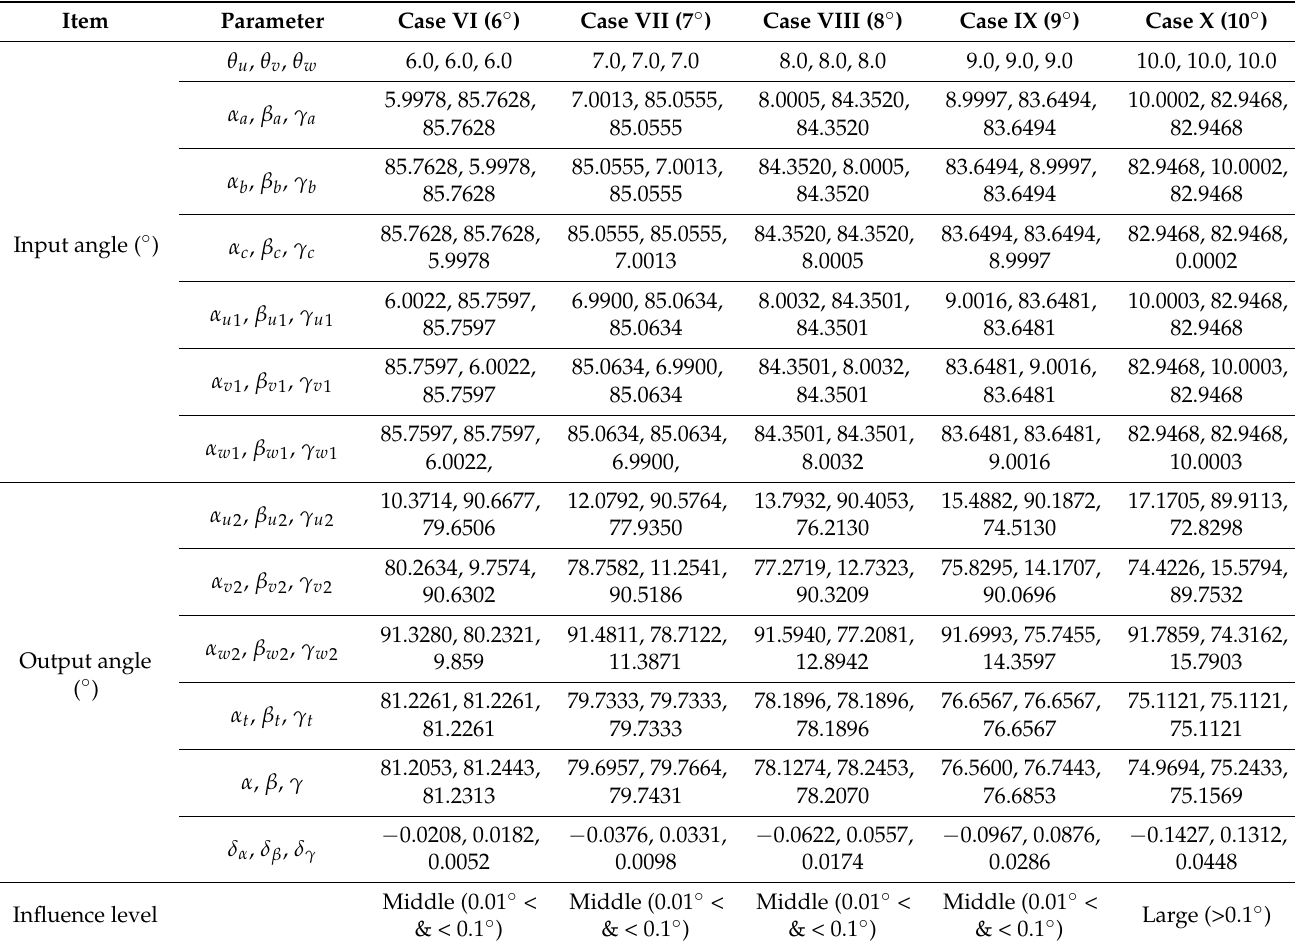
Table 3. The effects of error sources on orthogonality estimation under the angles: 6 ◦ –10 ◦